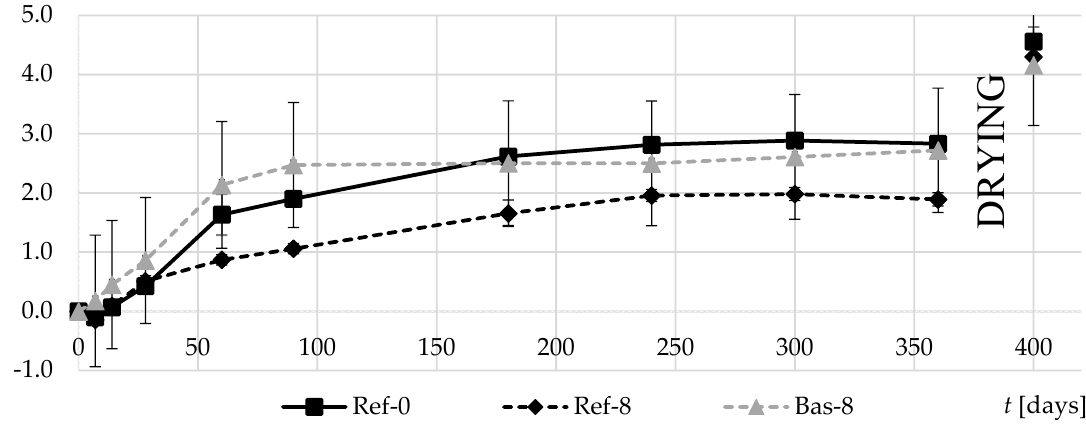
Figure 15. Average relative mass reduction of composites in the first 360 days of curing.